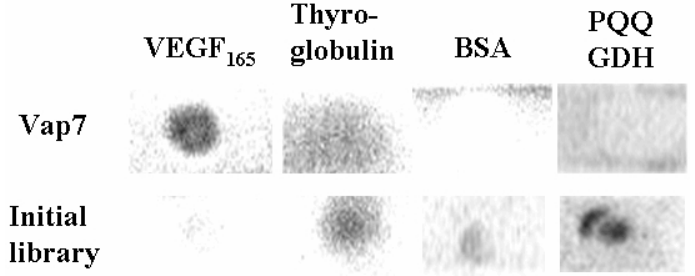
Figure 2. Evaluation of specificity of Vap7. A 5-pmol aliquot of each of the proteins was immobilized on a single membrane. The membrane was incubated sequentially with 100 nM of the nucleic acid modified with FITC and with HRP-labeled anti-FITC